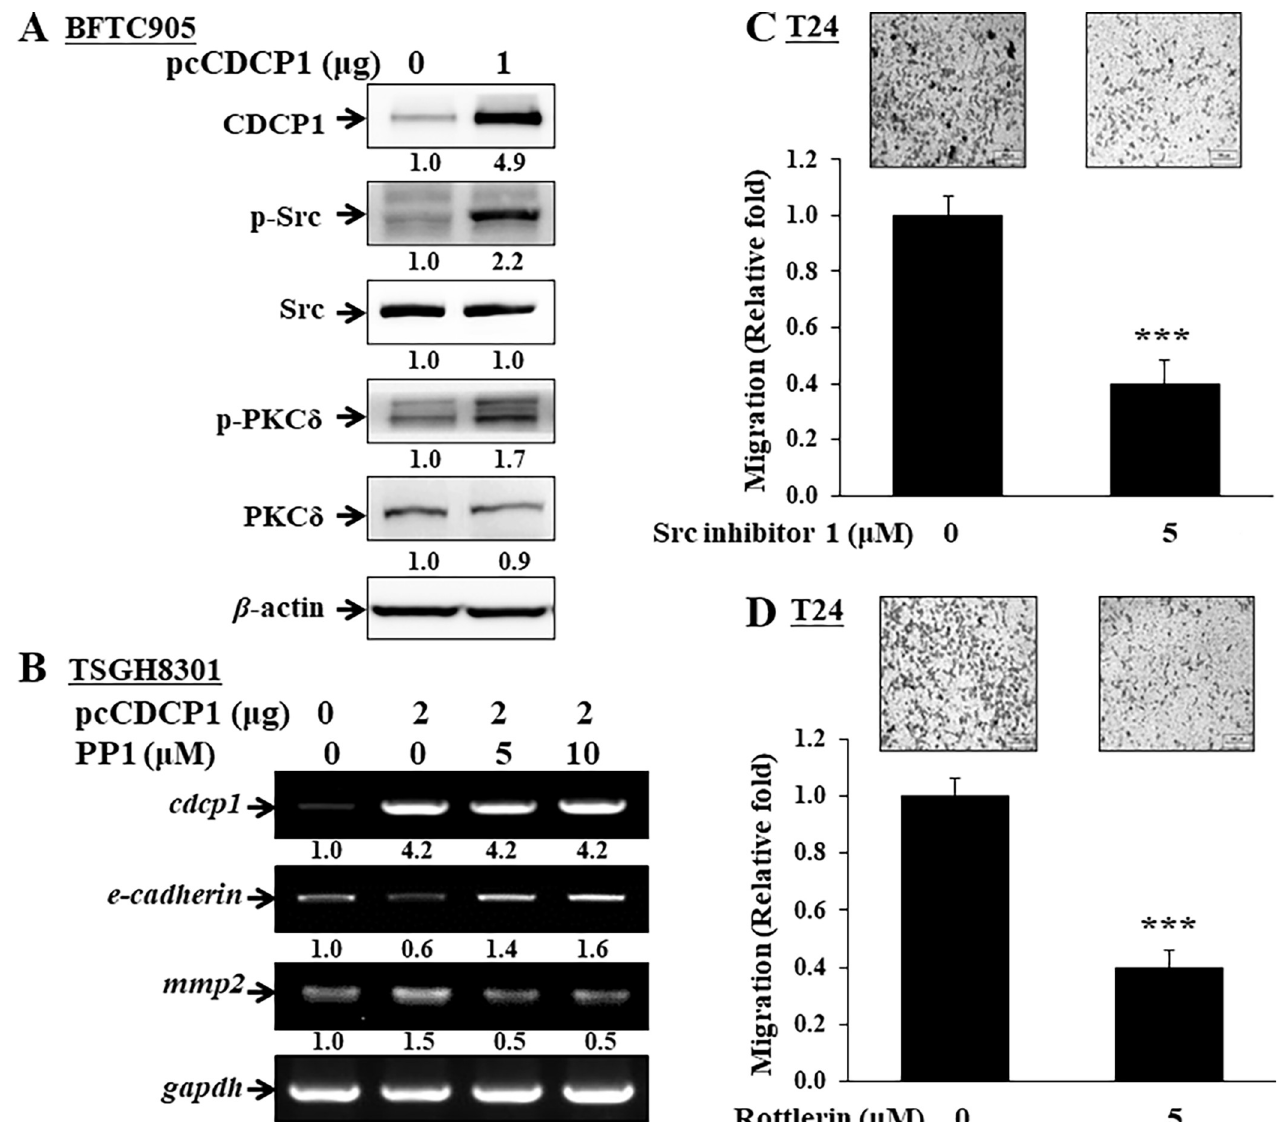
Fig 4. Involvement of c-Src/ PKC δ signalings in the CDCP1-regulated cellular migration abilities in UC cells. (A) BFTC905 cells were transfected with pcCDCP1 plasmids, and then harvested for the detection of phosphorylation of c-Src Y416 and PKC δ Tyr311 , respectively. (B) TSGH8301 cells were transfected with pcCDCP1 plasmids or with vector control for 24 hrs, then treated with specific Src inhibitor PP1 and harvested for the detection of mmp2 and e-cadherin mRNA expression. T24 cells were performed and treated with (C) specific c-Src inhibitor-1, or (D) PKC δ inhibitor rottlerin, respectively. Cellular migration abilities were measured as described in the “Materials and methods” section. Images of migration were taken at 200x magnification. Scale bar indicates 100 μ m. Statistical analyses were evaluated by unpaired two-tailed Student’s t-test. The results were presented as mean ± SD (n = 3, � p < 0.05, �� p < 0.01, ��� p <